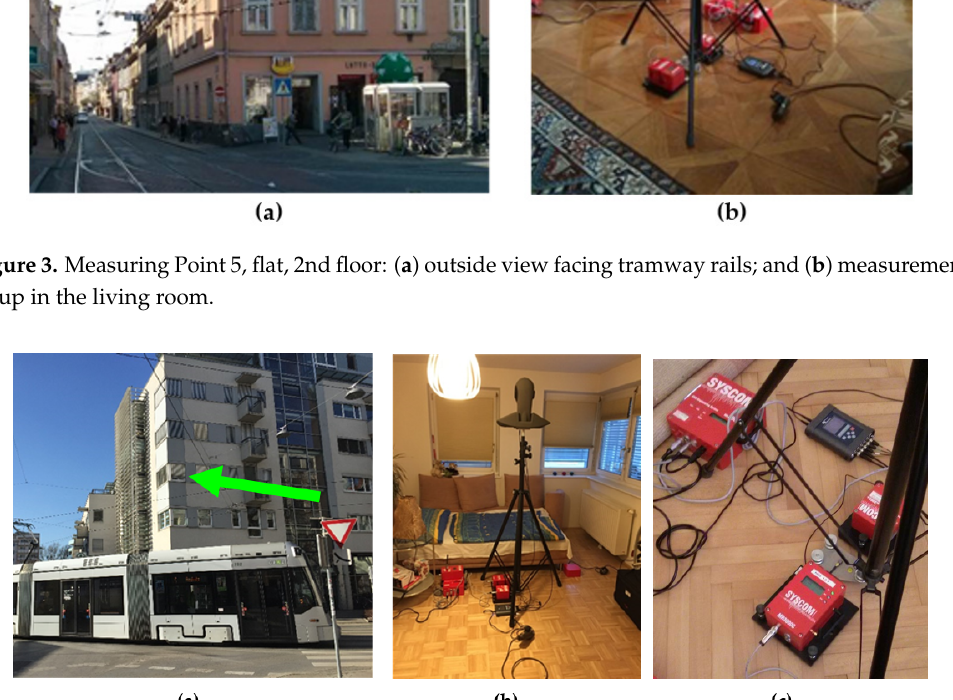
Figure 4. Measuring Point 6, flat, 2nd floor: ( a ) outside view facing tramway rails; ( b ) measurement setup in the bedroom; and ( c ) vibration measuring system with triaxial acceleration sensor based in the center of the room below dummy head measurement system.